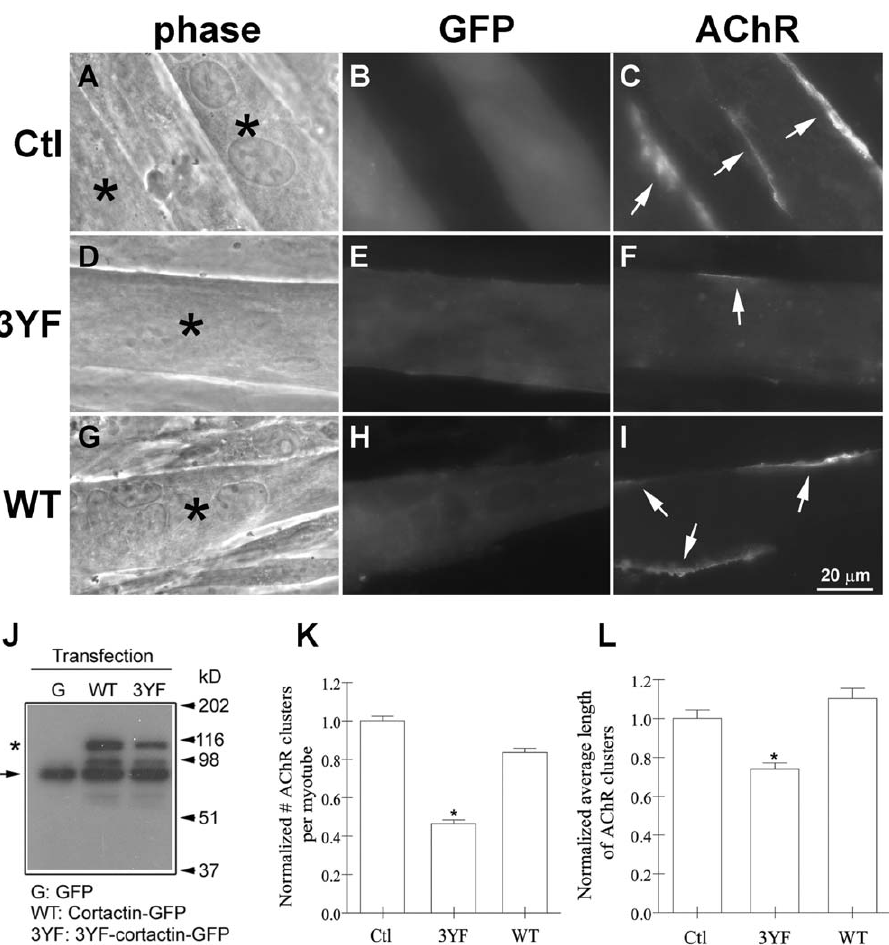
Figure 5. Inhibition of agrin-induced AChR clustering by forced expression of phospho-mutant cortactin in myotubes. To examine the effect of exogenous cortactin proteins on AChR clustering, C2 myotubes were transfected with mRNAs encoding GFP (Ctl) or GFP-tagged phospho-mutant (3YF) cortactin or wild-type (WT) cortactin. After treating myotubes with agrin overnight, cells expressing exogenous proteins (A, D, G; asterisks) were identified by green fluorescence (B, E, H) and the AChR clusters present on the surface of these cells were examined by R-BTX- labeling (C, F, I; arrows). Forced expression of the phospho-mutant, but not wild-type, cortactin reduced the number and lengths of agrin-induced AChR clusters in myotubes. J. To biochemically confirm the expression of exogenous cortactin proteins in myotubes, extracts prepared from myotubes transfected with mRNAs encoding GFP, GFP-tagged WT and 3YF cortactin were immuno-blotted with anti-cortactin monoclonal antibody mAb4F11. Myotubes transfected with GFP mRNA (G) contained full-length endogenous cortactin (arrow on left), but those transfected with WT- and 3YF-cortactin mRNAs contained endogenous cortactin plus a protein ( , 25 kD larger) corresponding to exogenous, GFP-tagged cortactin (asterisk). MW marker positions are indicated on the right. K-L. Myotubes transfected with GFP or GFP-tagged cortactin proteins were selected randomly and the numbers and lengths of the AChR clusters present on their surface were determined; data from five separate transfection experiments were pooled and normalized relative to values obtained from GFP-tranfected cells. Fewer (K) and smaller (L) AChR clusters were present in myotubes expressing phospho-mutant cortactin than in cells expressing GFP alone or WT-cortactin-GFP. Mean and SEM values are shown, *P , 0.05.